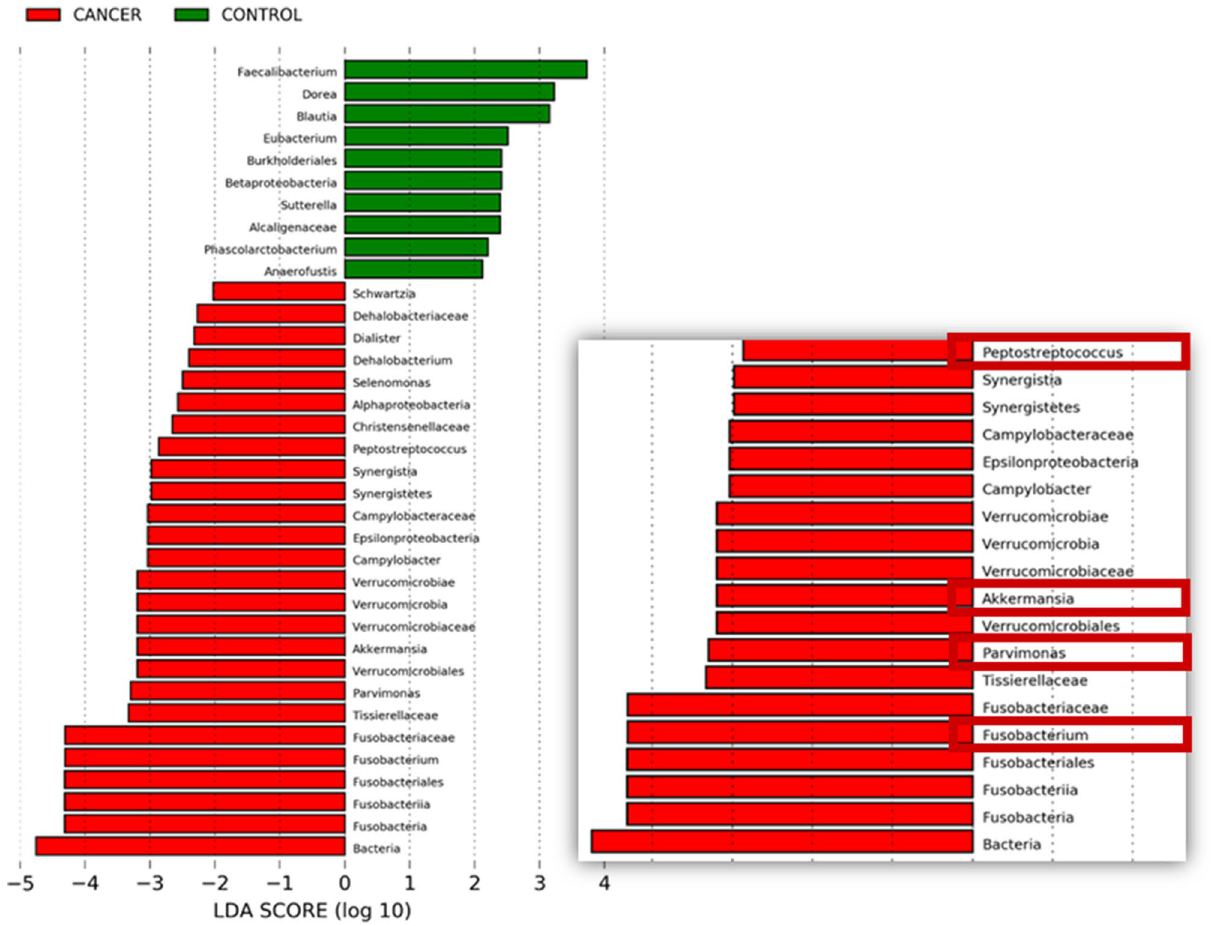
Figure 2. LEfSe analysis of bacterial taxa in CRC patients compared to non-CRC controls. LEfSe applies a Kruskal–Wallis rank-sum test, Wilcoxon rank-sum test, and linear discriminant analysis to determine the biological relevance of significantly-enriched taxa and ranks them by effect size. LDA score shows the magnitude of the effect